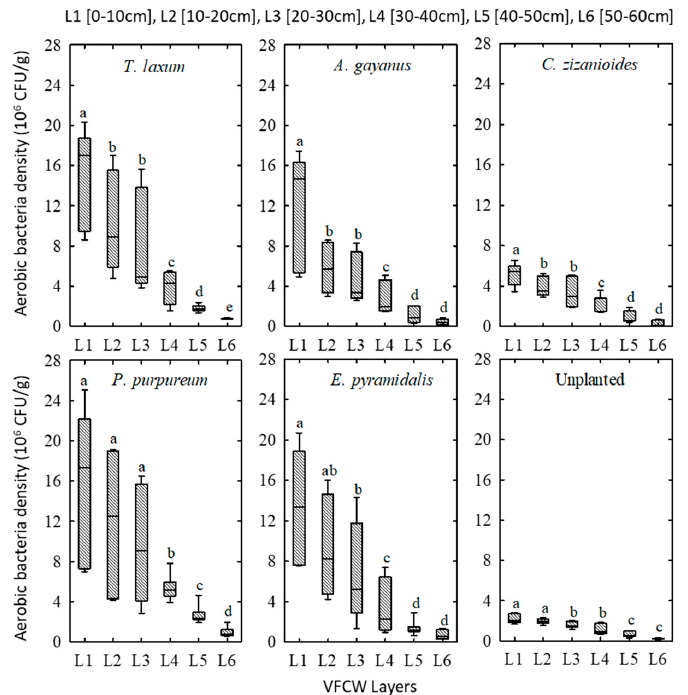
Figure 4. Vertical profile of aerobic bacteria density in the different substrate layers of the pilot VFCW beds from the upper to the bottom layers: L1 [0–10 cm], L2 [10–20 cm], L3 [20–30 cm], L4 [30–40 cm], L5 [40–50 cm], L6 [50–60 cm]. Box-plots bearing the same letter indicate no significant difference ( p > 0.05).